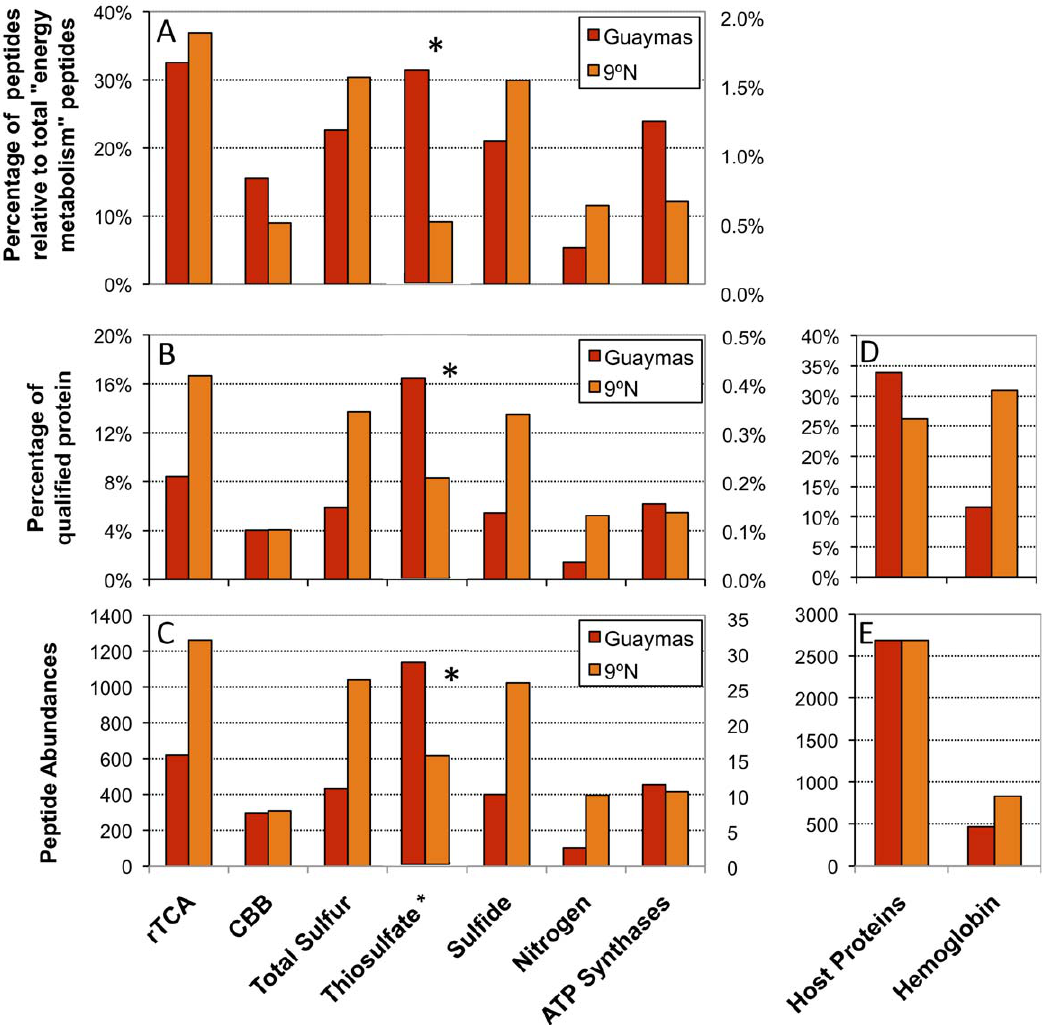
Figure 2. Comparing the Abundance of symbiont and host proteins recovered from Guaymas and East Pacific Rise (EPR) Riftia pachyptila . The categories along the x-axes refer to general or specific physiological processes. ‘‘rTCA’’ refers to reductive Tricarboxylic Acid cycle, and ‘‘CBB’’ refers to the Calvin Benson Bassham cycle. ‘‘Peptide abundances’’ refers to the number of peptides allied to qualified proteins associated with each process. ‘‘Qualified proteins’’ refers to those proteins that met the requisite criteria (see methods). Symbiont proteins were evaluated against the total, identified symbiont proteins, host hemoglobin against host proteins, and total host proteins against the sum of both host and symbiont proteins. A) Percentage of peptides, allied with the physiological processes shown on the x-axis, relative to all proteins categorized by C.O.G. as allied to ‘‘energy metabolism’’, B) Percentage of qualified symbiont protein associated with each category, C) Absolute number of peptides associated with each category, D) Percentage of qualified host protein allied to the host proteome, or specifically hemoglobin, and E) Absolute number of peptides allied to the host proteome, or specifically hemoglobin. Lists of proteins quantified for metabolic categories can be found in Table S1. *=Thiosulfate plotted on secondary axis. the use of nitrate or ammonia by Riftia symbionts, is clearly different between the two sites. Moreover, differences in the representation of proteins associated with carbon fixation and sulfur oxidation pathways further suggest differences in the physiological poise of the symbionts between these two sites. While Riftia’s symbionts reside deep within the hosts, and in hospite are never in direct contact with the environment, these data do suggest that the geochemical milieu does influence symbiont